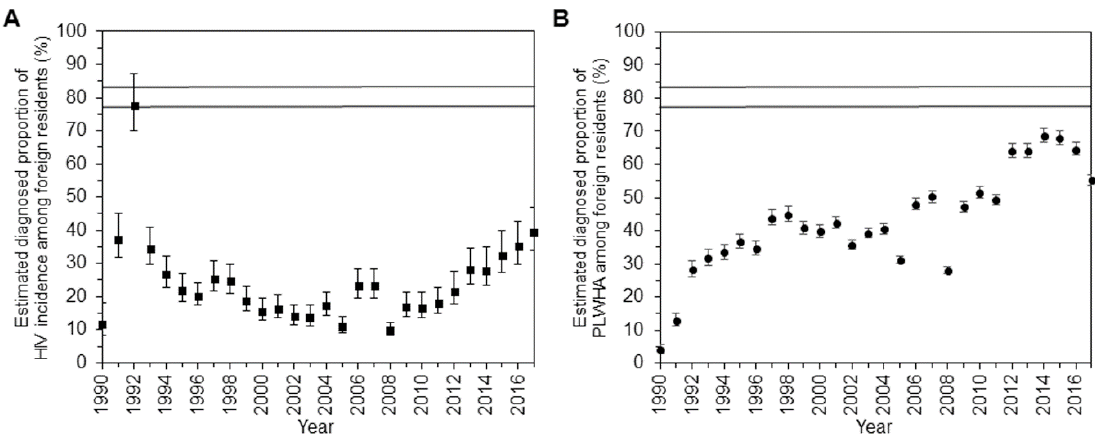
Figure 3. Overall estimate of diagnosed proportion of human immunodeficiency virus (HIV) infections among foreign residents in Japan, 1990 – 2017. ( A ) Estimates of the diagnosed proportion of the yearly incidence of HIV infections. ( B ) Estimates of the diagnosed proportion of the cumulative number of HIV infections and acquired immunodeficiency syndrome (AIDS) cases in 1990 – 2017. In both (A) and (B), whiskers extend to the upper and lower 95% confidence intervals. Two horizontal lines show the estimated diagnosed proportions among Japanese national; 77 – 84% [19].